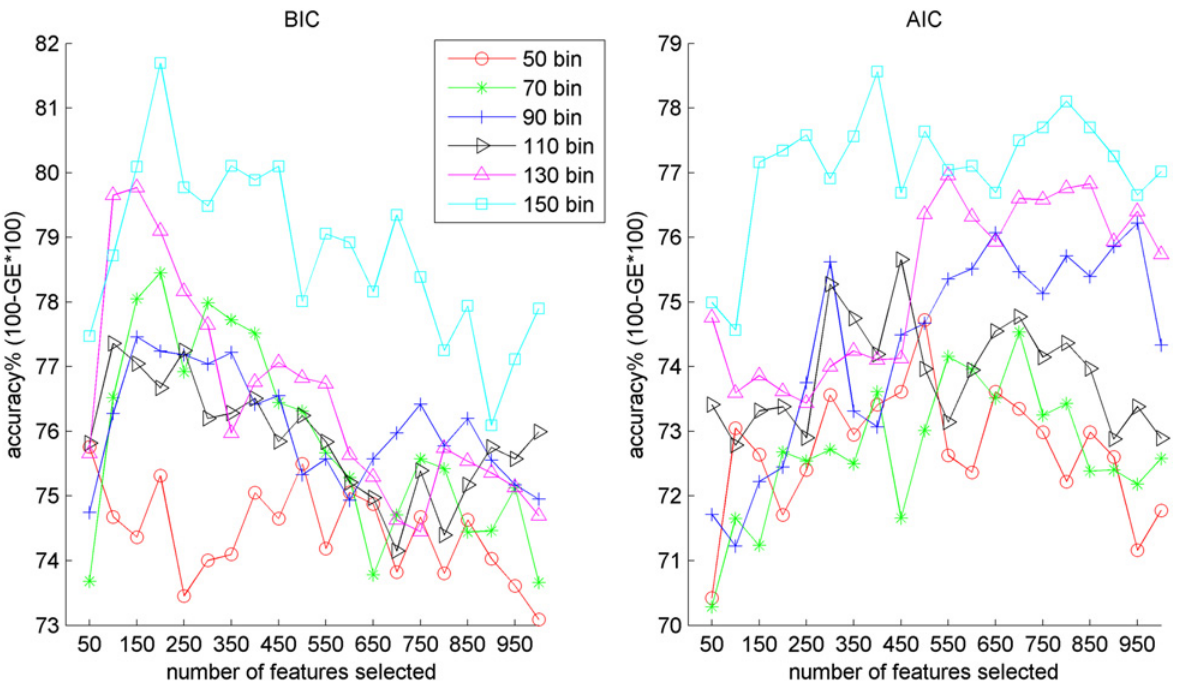
Fig 3. Number of features selected versus the classification accuracy using pSMC normalization. Results are obtained by using the ADNI dataset on MCI against AD. Accuracy of BIC tend to drop after selecting 150 features, and AIC tends to drop after